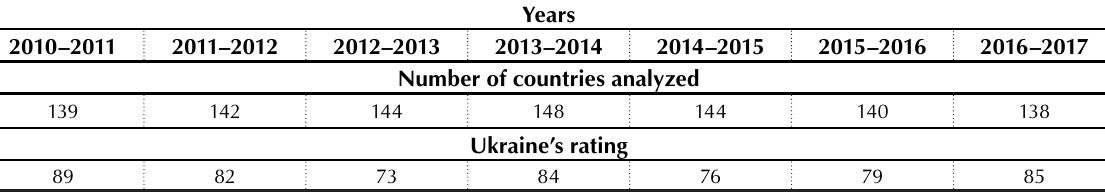
Table 4. Dynamics of Ukraine’s position changes in the Global Competitiveness Index